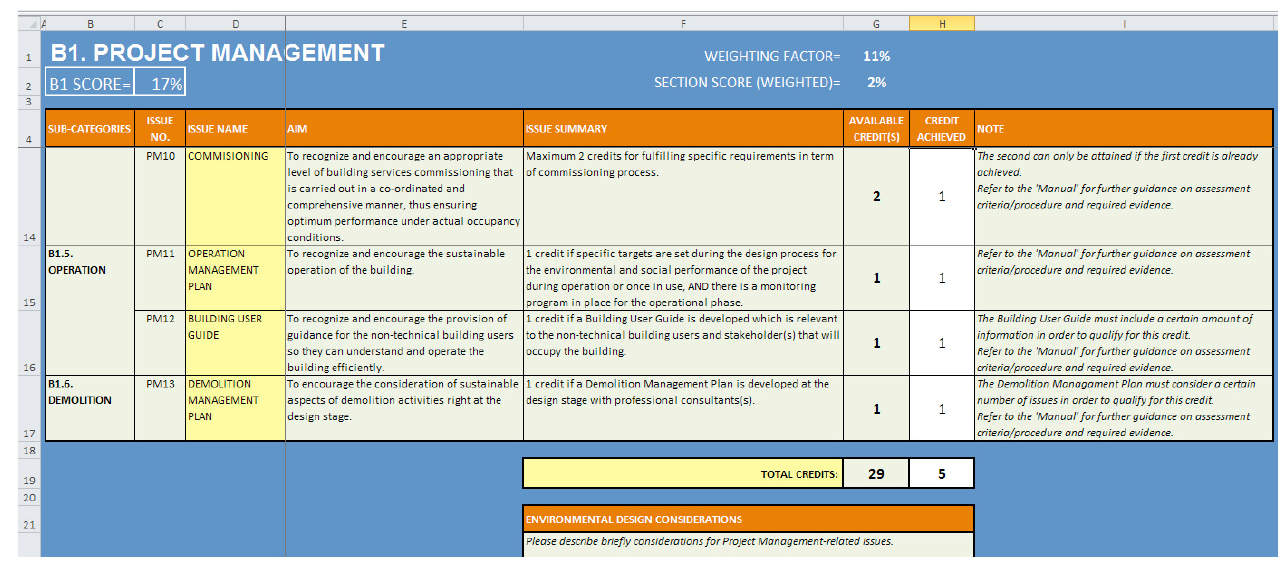
Figure 5. Sample screenshot of an Assessment